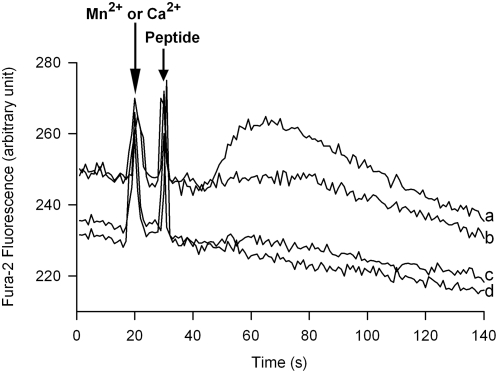
Specificity of the Ca2+ entry provoked by 50 µM CHR and 20 µM CAT.Characterization by spectrofluorimetry of the specificity of the Ca2+ entry induced by 50 µM CHR or 20 µM CAT for comparison with peptide effects on Mn2+ entry. Simultaneous recordings of fluorescent intensity variations of PMNs loaded with Fura-2 in the presence of 1 mM CaCl2 (a, b) and 0.2 mM MnCl2 (c, d) at the corresponding wavelengths of excitation λEx340 nm and λEx360 nm. Divalent cations and peptides were added as indicated by arrows. Recordings are representative of three experiments.